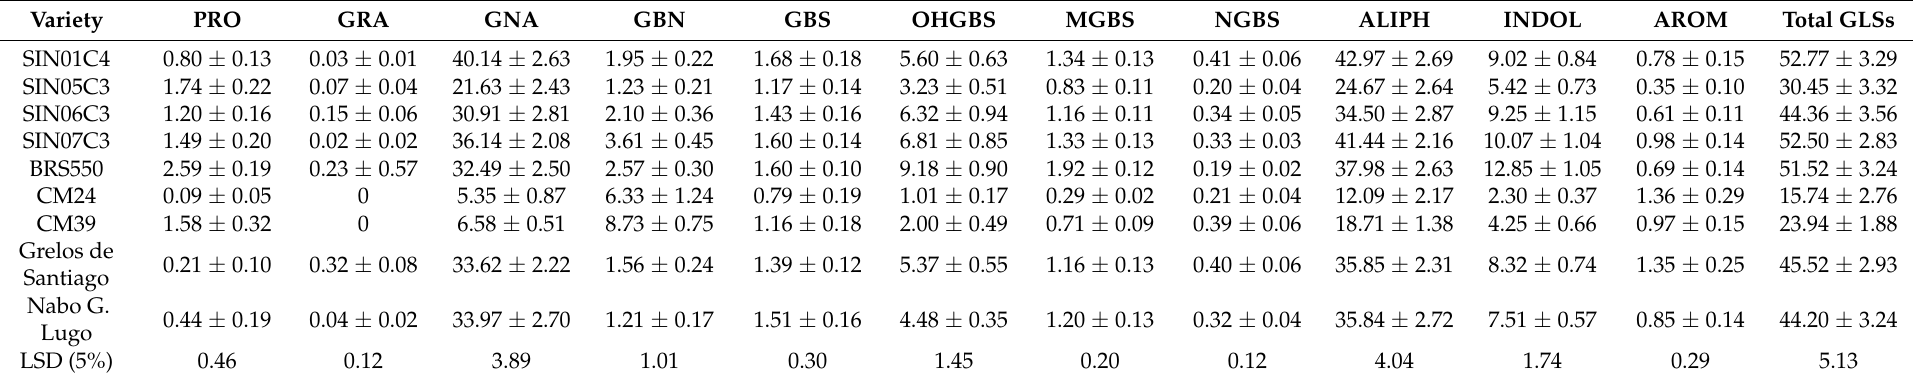
Table 4. Mean ( µ mol gram − 1 dw) glucosinolate content in turnip greens from the B. rapa varieties evaluated at three environments in Northwestern Spain and two environments in Italy. Variety